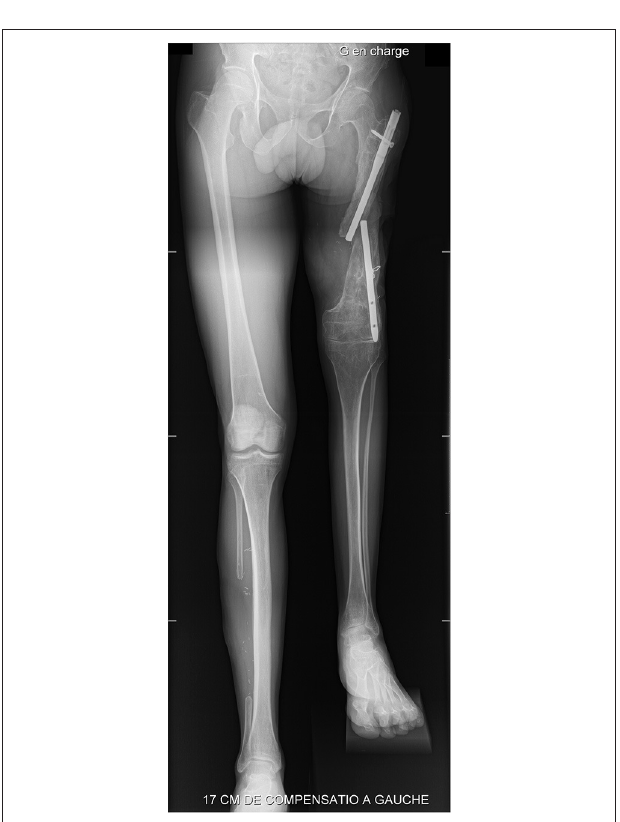
FIGURE 2 | Pre-operative weight-bearing full-length lower limb X-ray showing major limb length discrepancy (17cm).